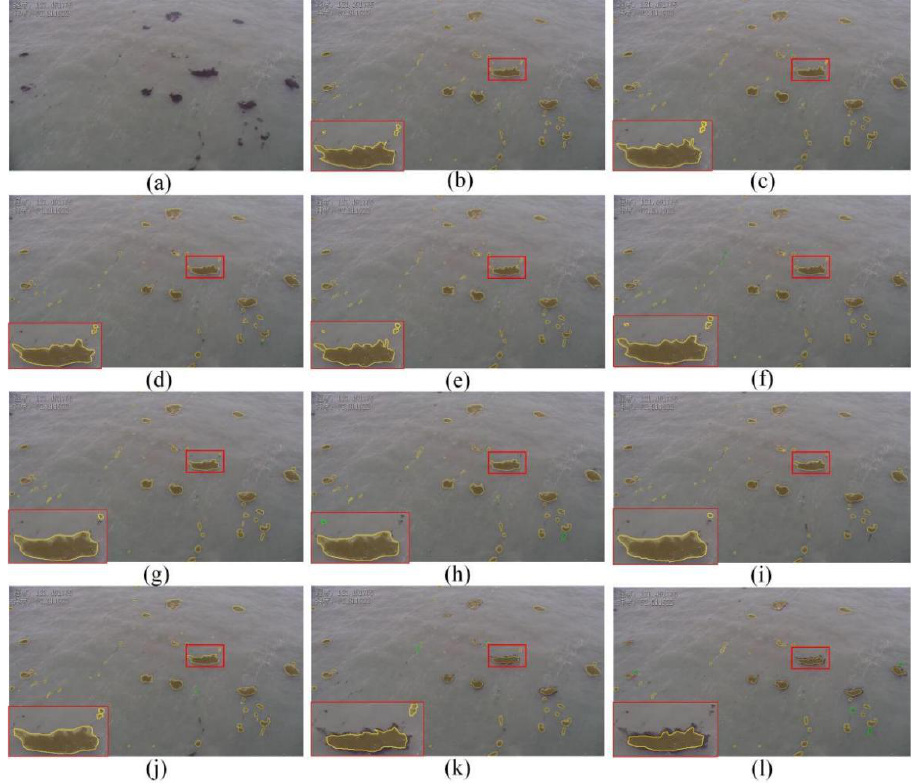
Figure 17. The visual comparison of results of different models in scene 4.